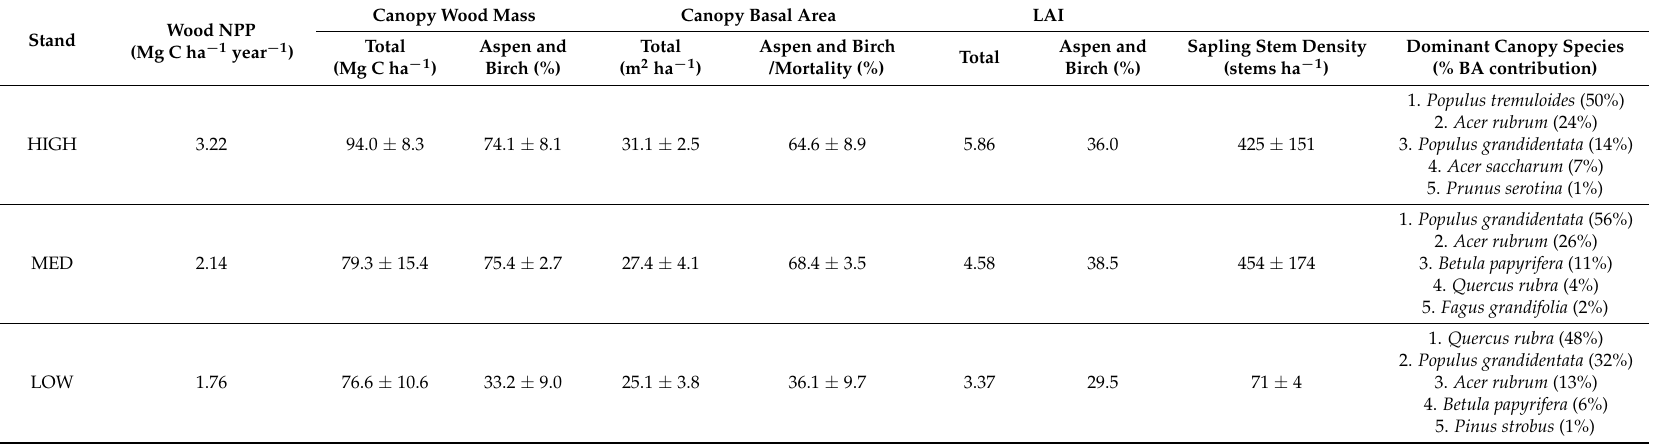
Table 1. Pre-disturbance aboveground wood net primary production (Wood NPP; 1997/1998–2001), wood mass (2001/2006), aspen and birch wood mass (% of total), basal area (BA; 2001/2006), aspen and birch BA (% of total), leaf area index (LAI; 2007), aspen and birch LAI (% of total) for each stand, sapling stem density of trees with a diameter at breast height (DBH) between 4–7.9 cm, and the five most dominant species (based on % basal area; 2001/206). Years cited in parentheses above reference the inventory year from which data were supplied. Mean ±